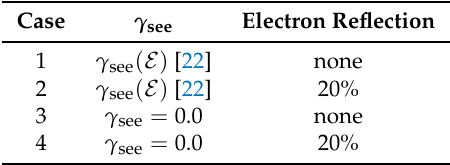
Table 3. The four cases explored for each